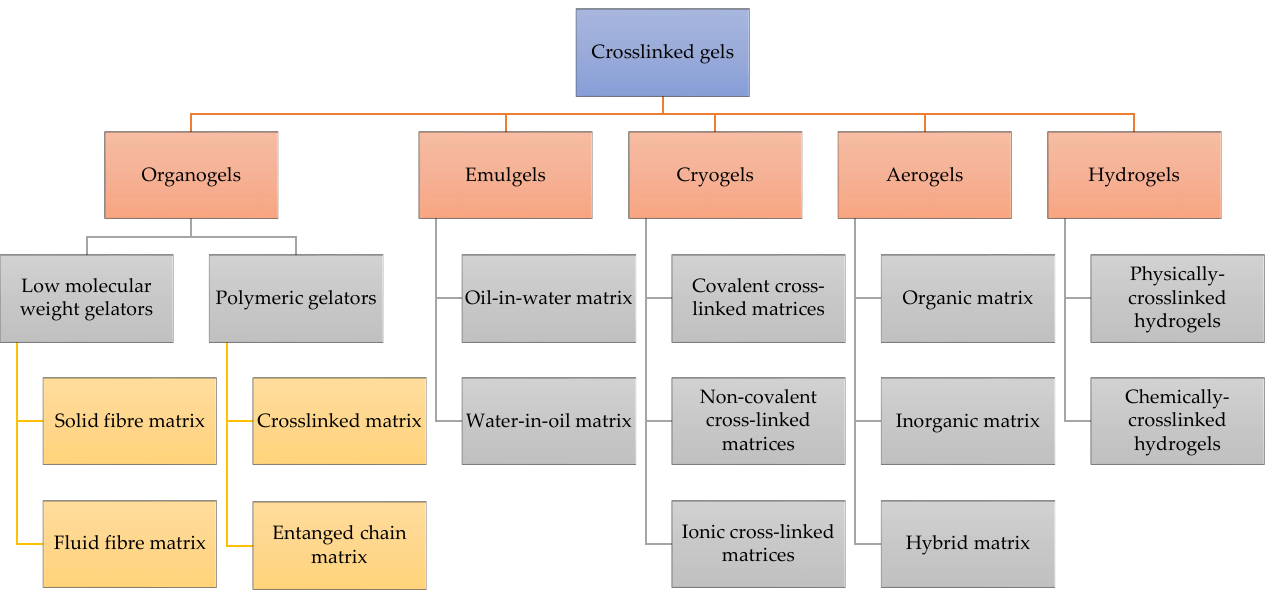
Figure 2. Classifications of cross-linked gels based on the nature of solvents.